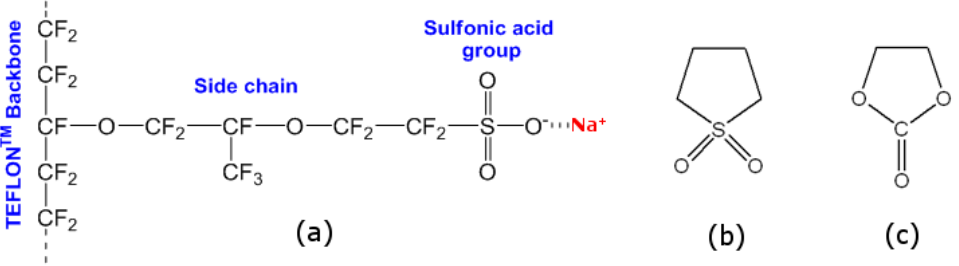
Figure 1. Structural formulas of ( a ) Na-Nafion, ( b ) sulfolane, and ( c ) ethylene